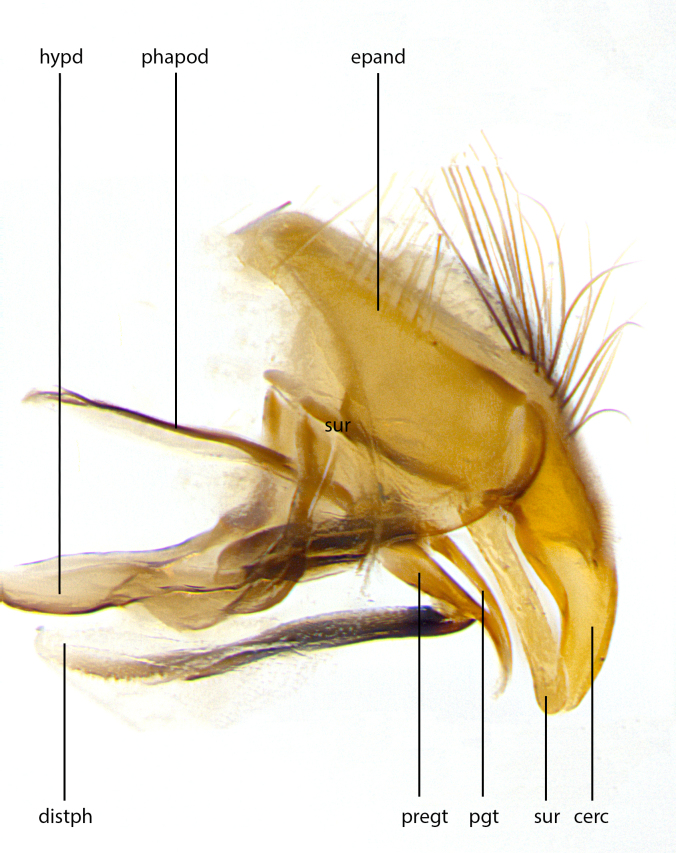
abbreviations: cerc = cercus; distph = distiphallus; epand = epandrium; epiph = epiphallus; hypd = hypandrium; phapod = phalloapodeme; pgt = postgonite; pregt = pregonite; sur = surstylus.